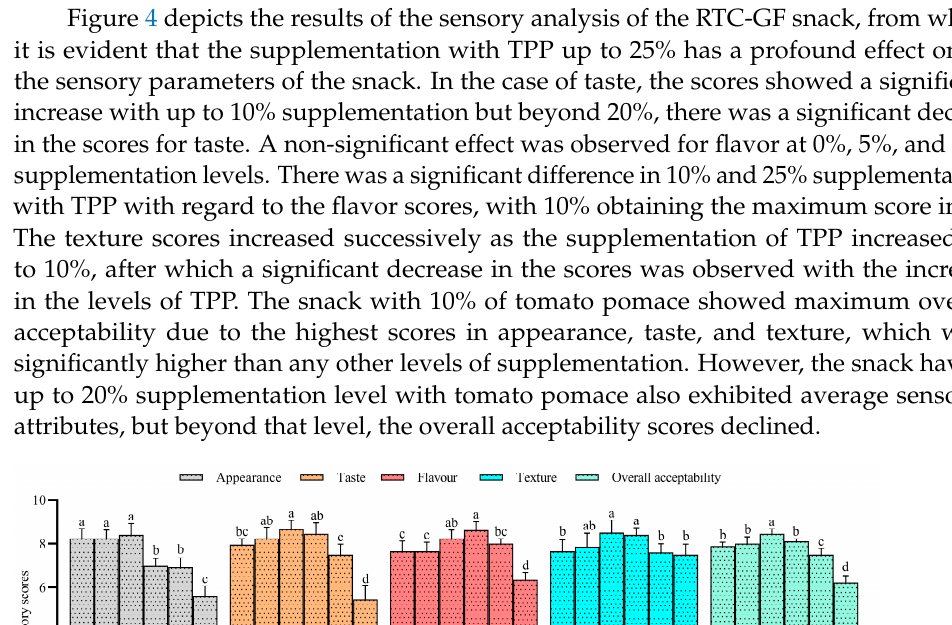
Figure 3. Cooking analysis: ( a ) Effect of addition of tomato pomace powder on the frying time and hardness of ready-to-cook gluten-free snack; ( b ) Effect of addition of tomato pomace powder on the oil uptake and cooking loss of ready-to-cook gluten-free snack.